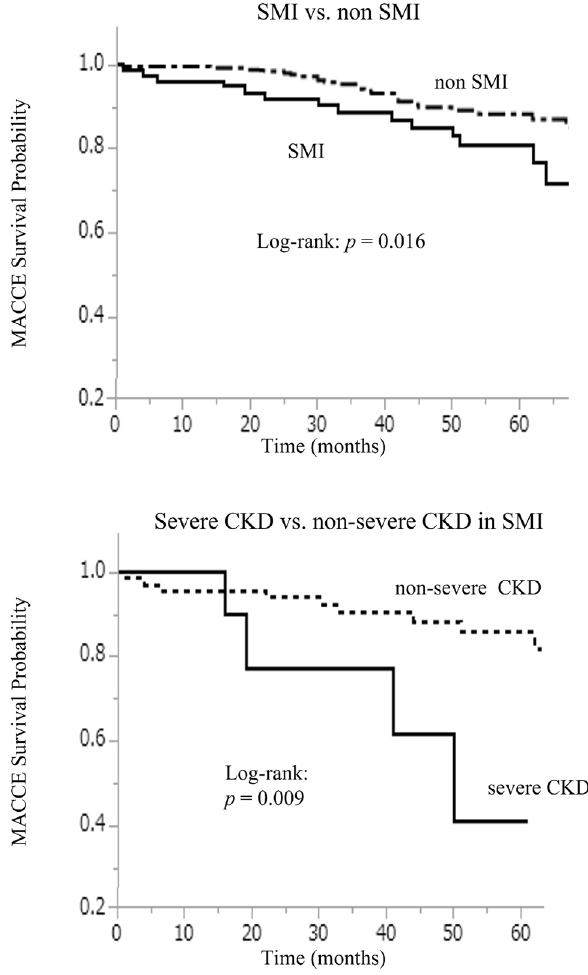
Figure 3. The prognosis of SMI. The median follow-up duration after diagnosis was 35 (15–57) months in the entire cohort of 461 patients with diabetes. The clinical outcomes were poorer in patients with SMI. The severe CKD subgroup (> stage 3a) had a poorer prognosis than that of the non-severe CKD subgroup among the patients with SMI. SMI silent myocardial ischaemia, CKD chronic kidney disease, MACCE major adverse cardiac and cerebrovascular events.